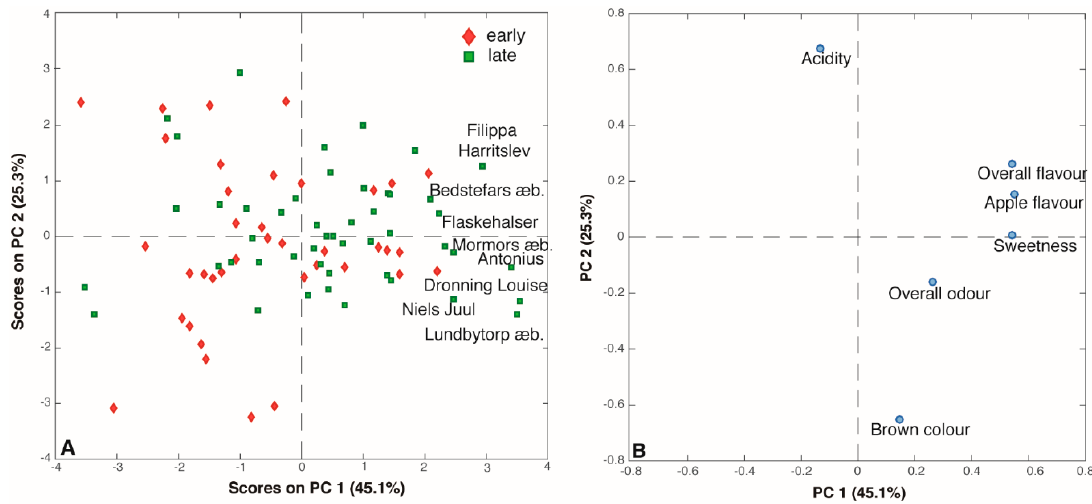
Figure 4 . (A) Score and (B) loading plots of the PCA performed on the sensory analysis